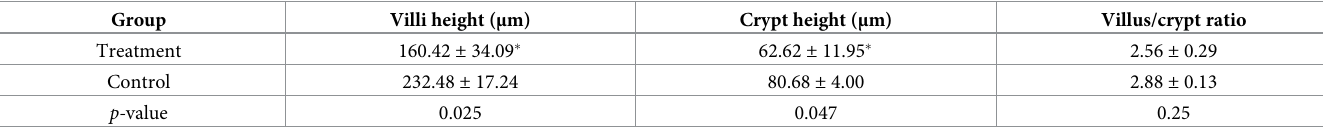
Data are expressed as mean ± SD.